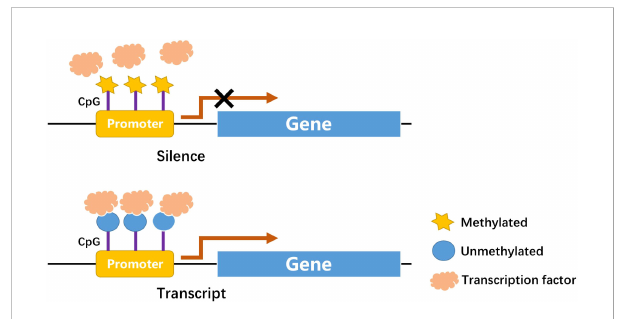
FIGURE 1 CpGs at promoter site: Methylation in CpGs leads to gene